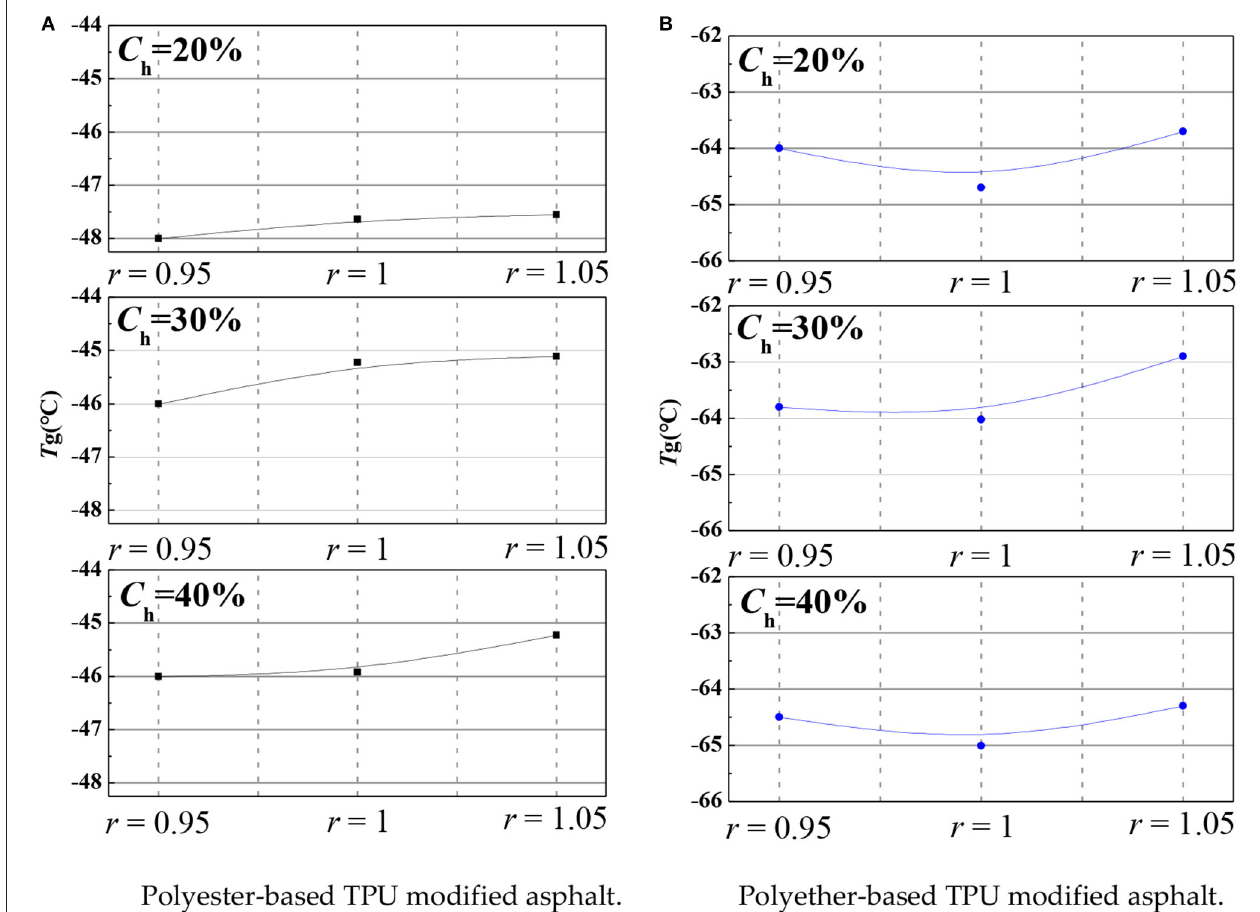
FIGURE 27 | T g of different samples. (A) Polyester-based TPU-modified asphalt. (B) Polyether-based TPU-modified asphalt.